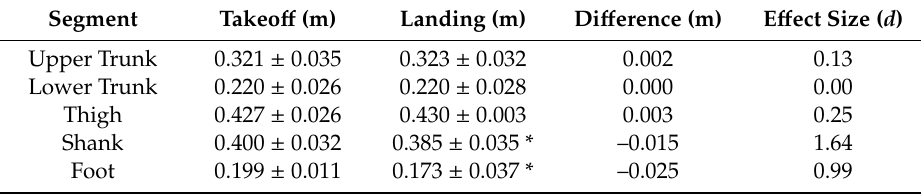
Table 2. The vertical component of the segment length (SEG k ) at takeo ff and landing.